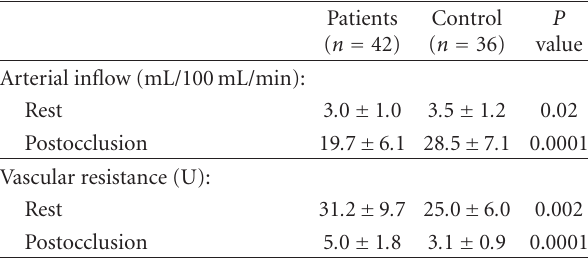
Table 2: Forearm arterial indices.